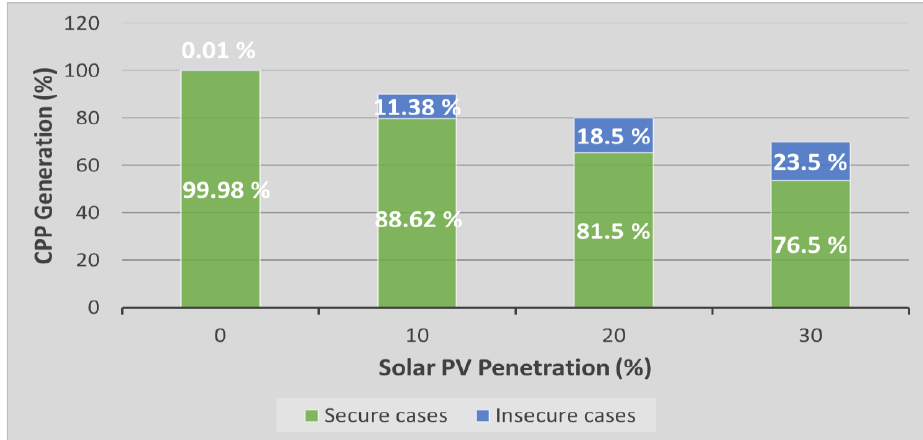
Figure 7. Summary of frequency stability analysis for different PV penetration levels.